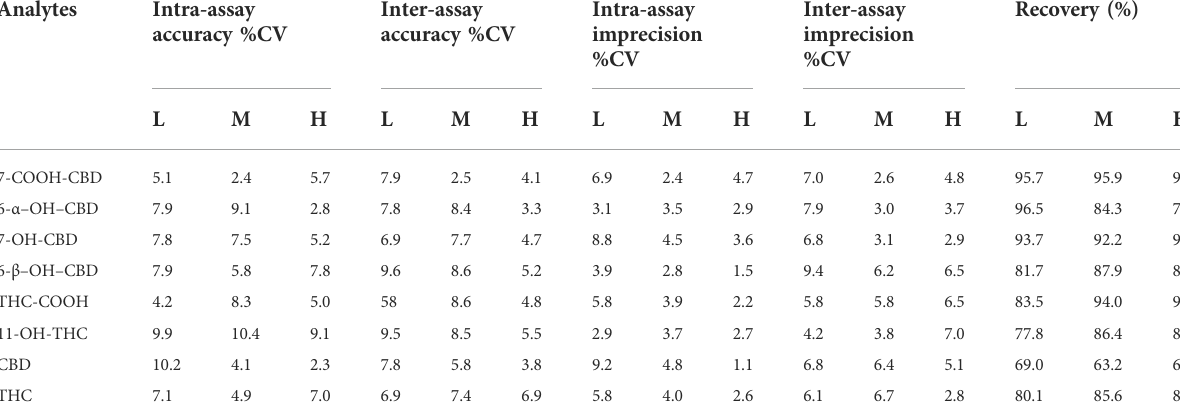
TABLE 4 Validation parameters for cannabinoid analytes under investigation in blood samples. Analytes